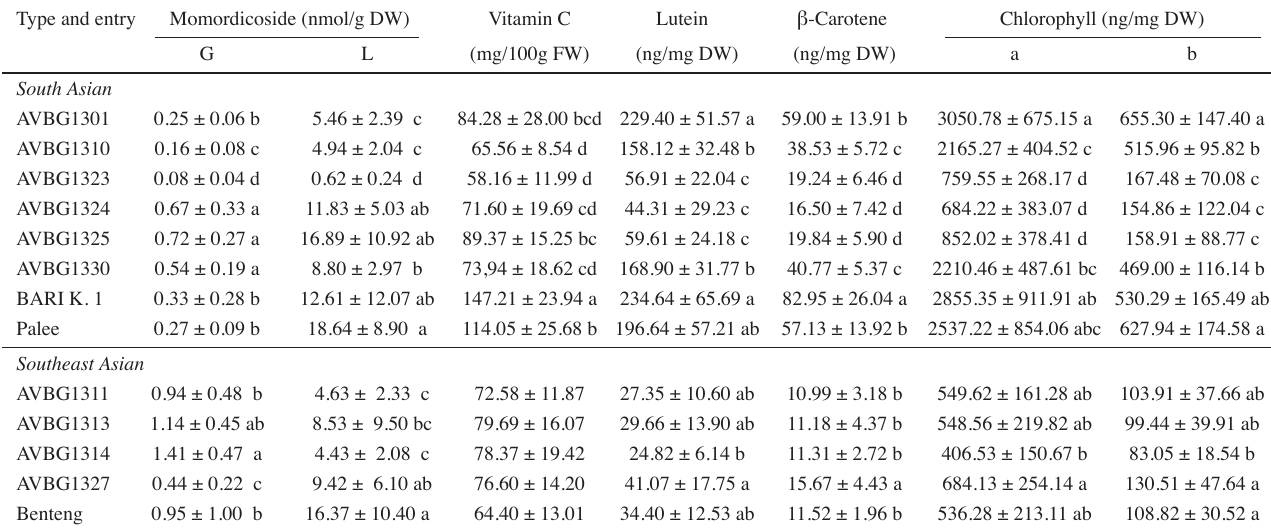
Tab. 2: Secondary metabolite contents of South Asian and Southeast Asian type bitter gourd fruits from 10 breeding lines and cultivars grown in a greenhouse, Karlsruhe, Germany, October 2014 to February